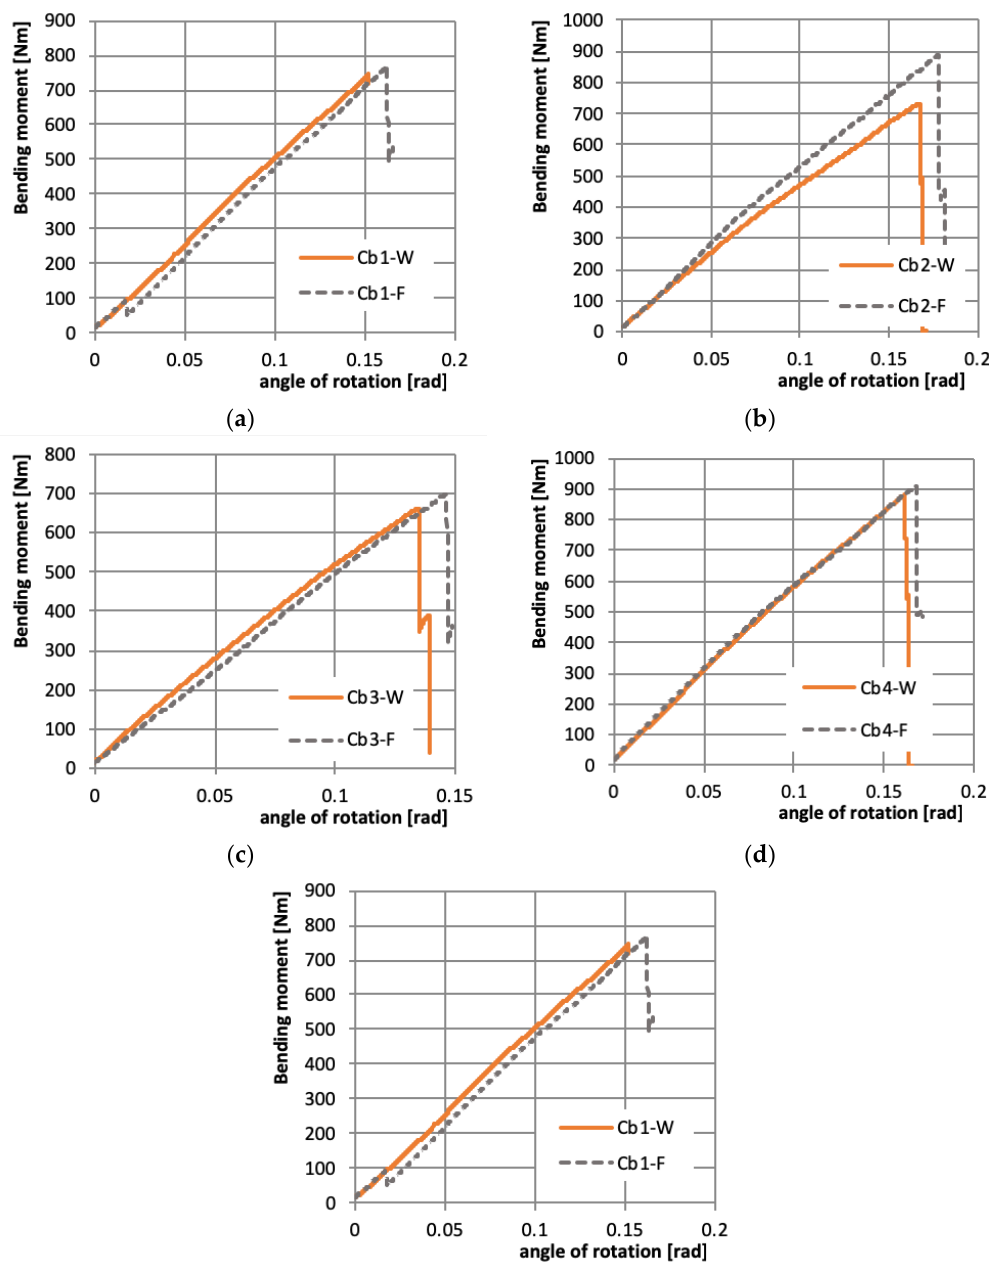
Figure 7. Bending moment vs. angle of rotation at support for pre-damaged beams with different layer arrangements. ( a ) beams with layups Cb1; ( b ) Cb2; ( c ) Cb3; ( d ) Cb4; ( e ) Cb5.